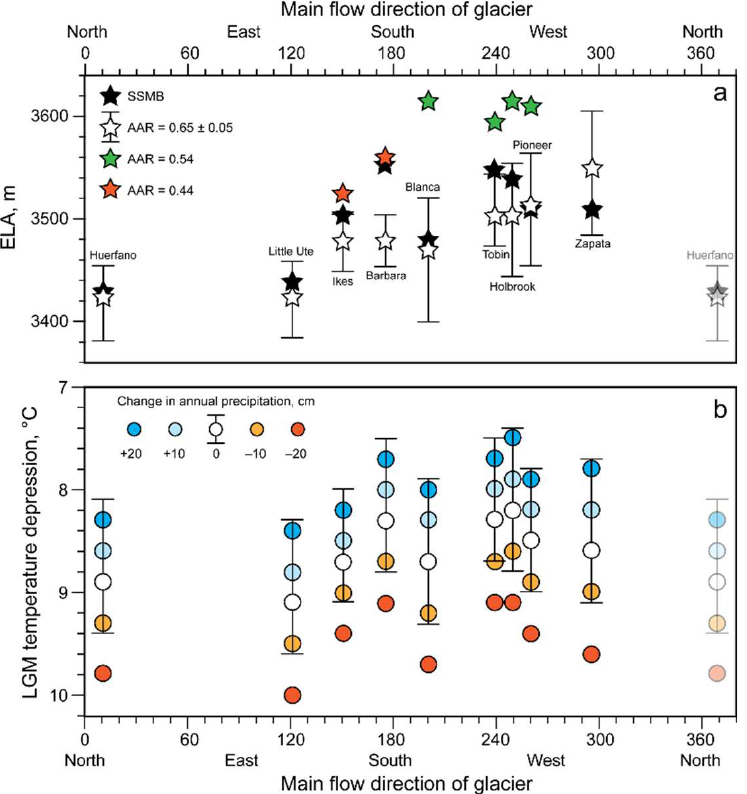
Figure 6. ( a ) Variations of AAR-derived ELAs and those for steady-state mass balance (SSMB) of the paleoglaciers with respect to the flow direction in the main valley. Uncertainties in ELAs derived using an AAR of 0.65 reflect a ±0.05 in AAR. See text and Table 1 for explanation of alternative estimates of AAR-derived ELAs where applicable. ( b ) Required temperature depression for assumed changes in LGM precipitation. Uncertainties in temperature depression assuming no change in LGM precipitation reflect those in the melt factors. Note values for Huerfano glacier are shown twice to help visualize directional